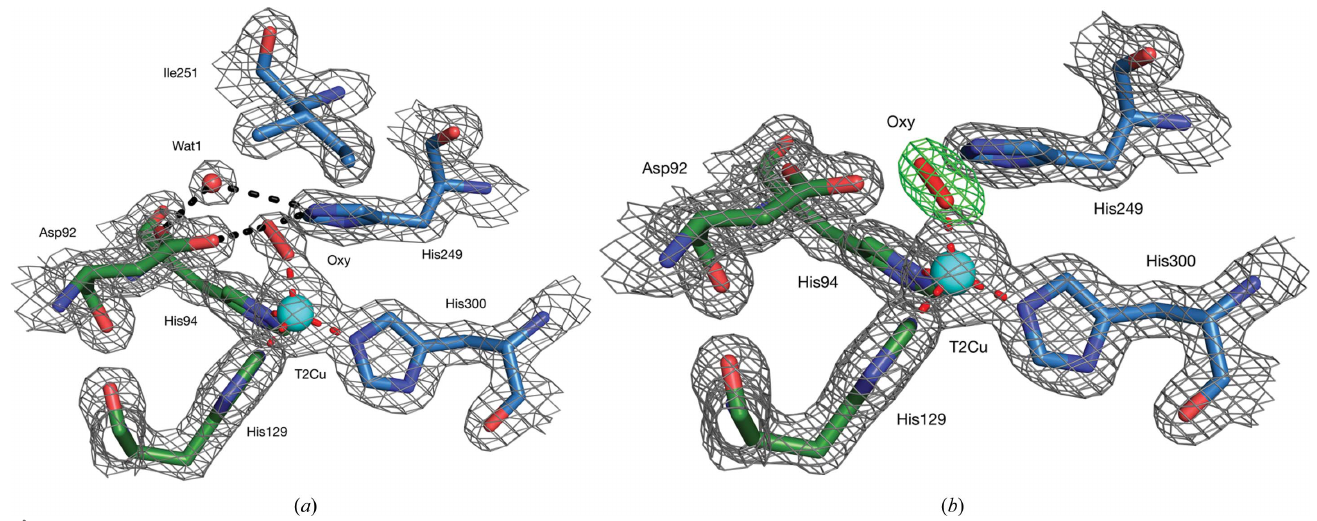
Figure 3 The T2Cu site as determined using femtosecond X-ray pulses. ( a ) 2 F o (cid:3) F c electron-density map of the SF-ROX Ax NiR T2Cu site. Electron density is contoured at 2 (cid:5) around the residues and ligands of the T2Cu site as a grey mesh. An oxygen diatom is ligated to the T2Cu in place of the normally observed water molecule. The O 2 /superoxide is ligated by the catalytic residues Asp92 CAT and His249 CAT , which in turn are hydrogen-bonded to the linking water. ( b ) A simulated-annealing OMIT map showing the dioxygen ligand bound to the T2Cu site. A 2 F o (cid:3) F c electron-density map contoured at 2 (cid:5) in grey mesh around the residues and Cu atom is shown superimposed with a ligand F o (cid:3) F c electron-density map contoured at 5 (cid:5) in green mesh around the refined dioxygen ligand. Atoms are coloured by element, with a different colour scheme used for the different chains. T2Cu, cyan sphere; water molecules, small red spheres; oxygen diatom, red sticks. Metal-coordinating bonds are shown as red dotted lines. Selected hydrogen bonds are shown as black dotted lines.